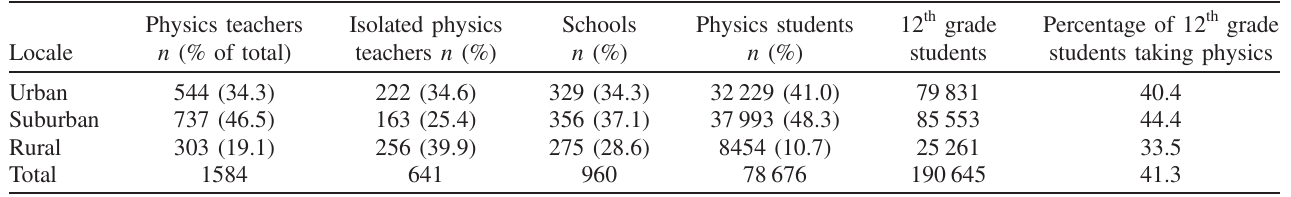
TABLE III. Distribution of physics teachers, schools, students, and isolated teachers by locale. Physics teachers n (% of total) Locale